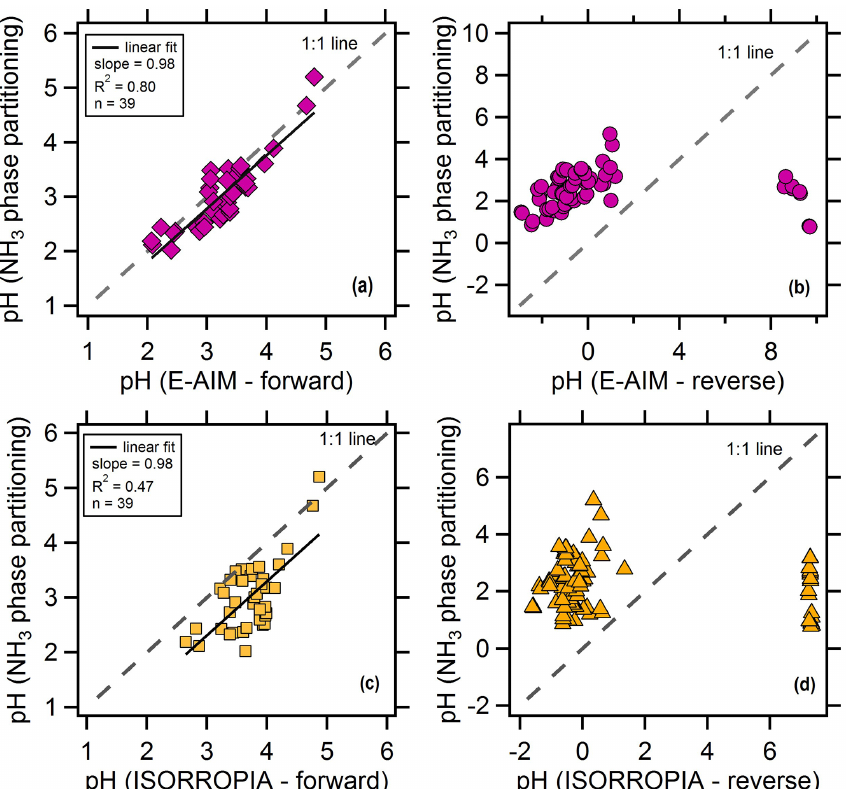
Figure 4. Aerosol pH predicted by the phase partitioning of ammonia compared to pH predicted by (a) E-AIM in the forward mode, (b) E-AIM in the reverse mode, (c) ISORROPIA in the forward mode, and (d) ISORROPIA in the reverse